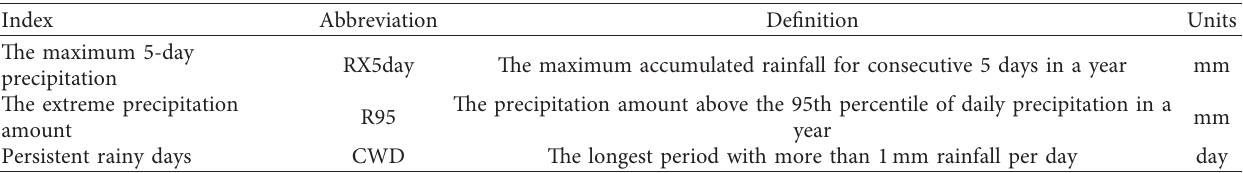
Table 2: The indices for extreme